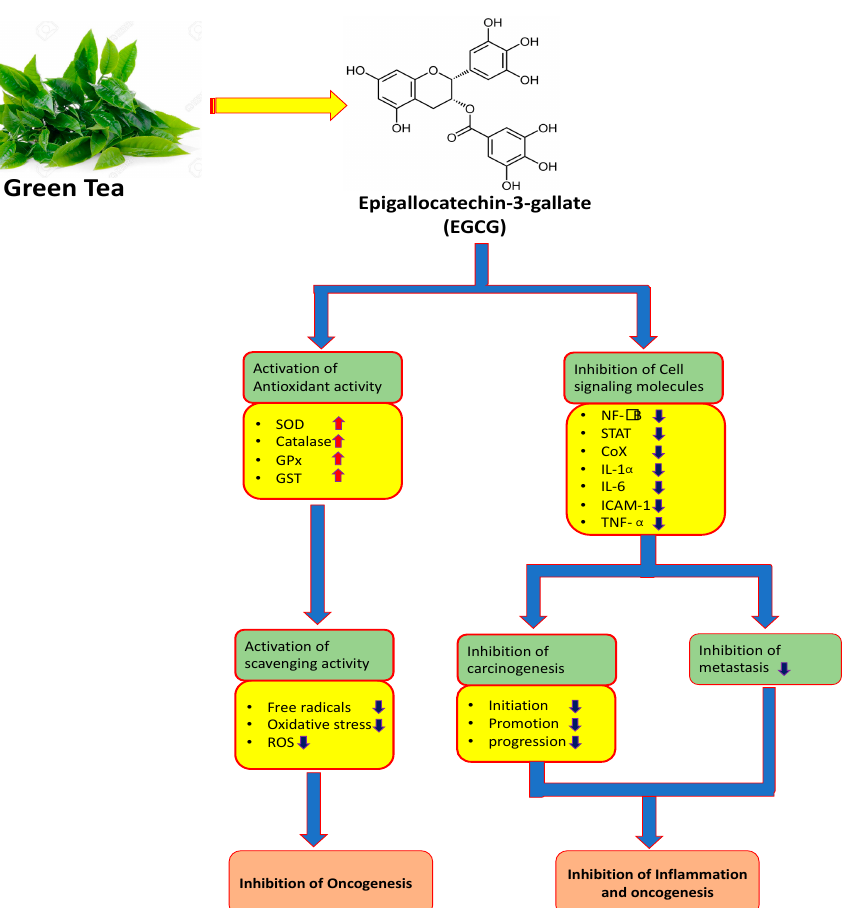
Figure 2. EGCG shows role in the inhibition of inflammation and inhibition of oncogenesis through the abrogation of the reactive oxygen.